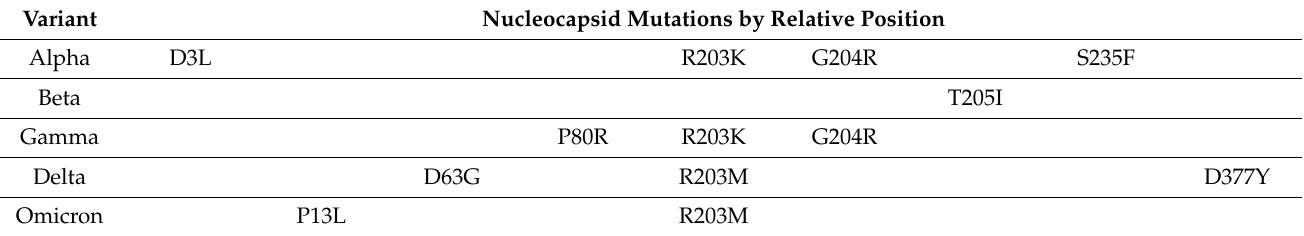
Table 1. Nucleocapsid protein mutations of the SARS-CoV-2